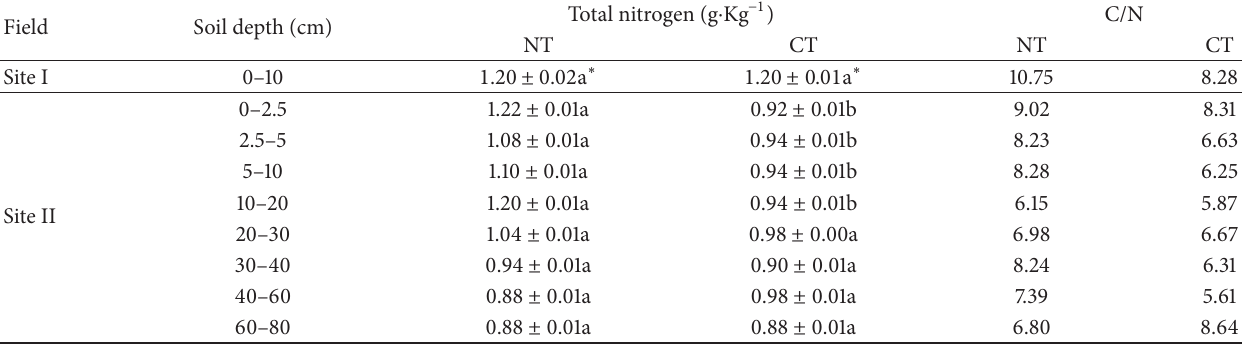
Table 4: Tillage treatments effect on total nitrogen (mean ± standard deviation) and on C/N ratio.